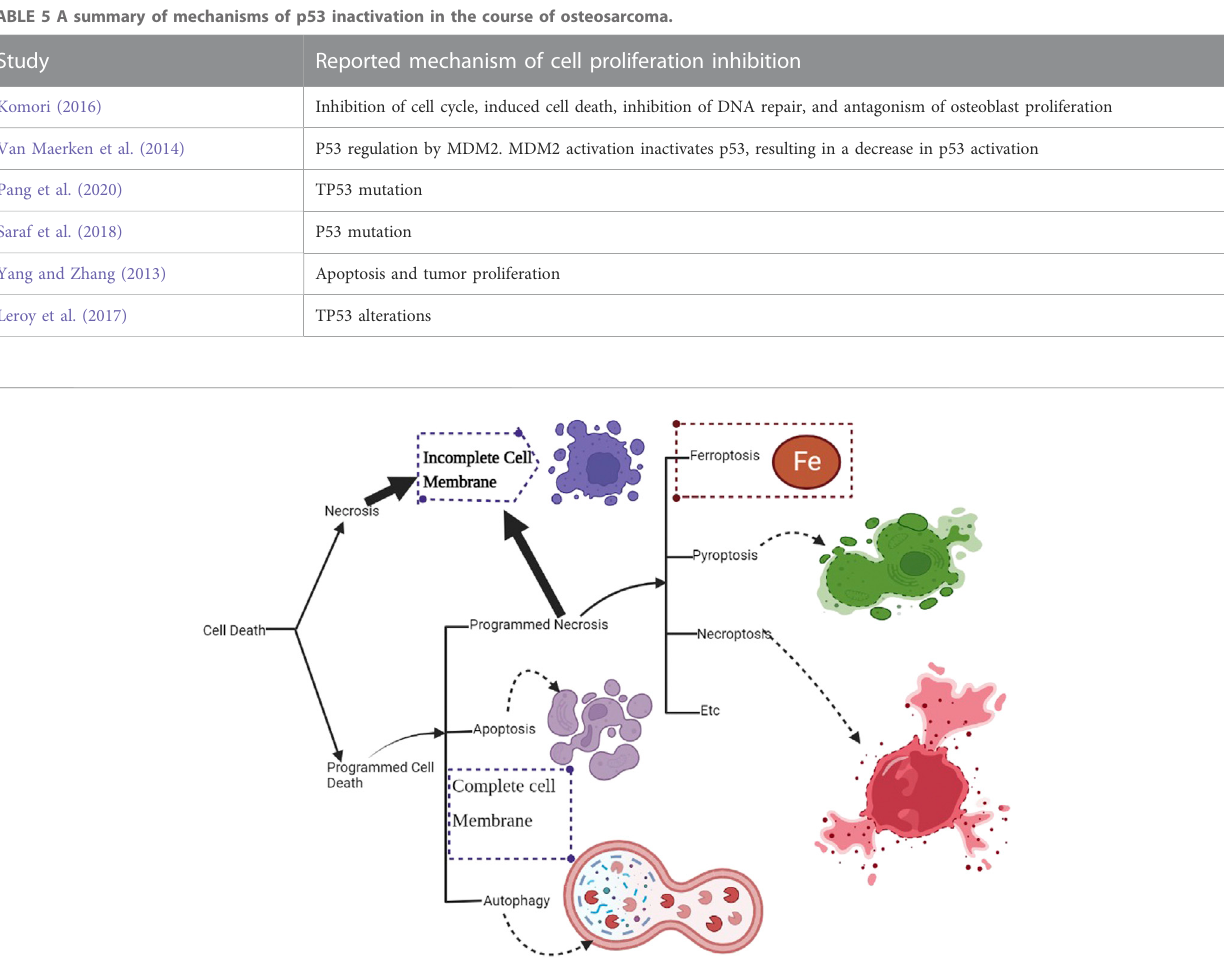
TABLE 5 A summary of mechanisms of p53 inactivation in the course of osteosarcoma.